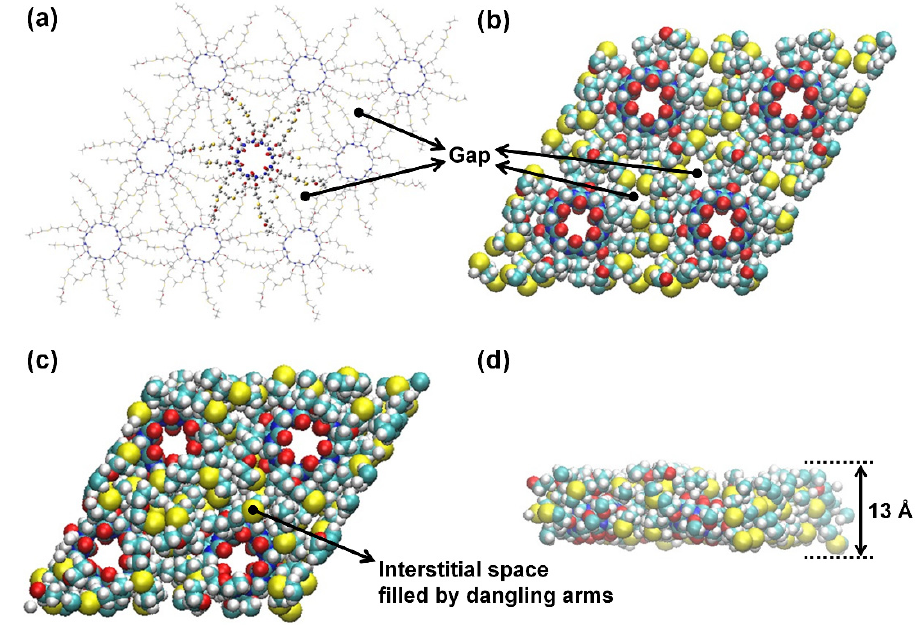
Figure 2. Top view of the 2D CB[6] nanosheet with ( a ) sticks and ( b ) spheres models at 0 ns. ( c ) Top view and ( d ) side view of the 2D CB[6] nanosheet at 10 ns. The gaps between the neighboring CB[6] units observed at 0 ns were determined to be filled by the dangling arms, which were intended to form a thicker and denser hydrophobic region. Once the dangling arms agglomerated to fill the empty interstitial space, the hydrophobic region (about 13 Å) became thicker than the height (9.1 Å) of CB[6]. Color scheme: N, blue; C, cyan; O, red; H, white; S, yellow.